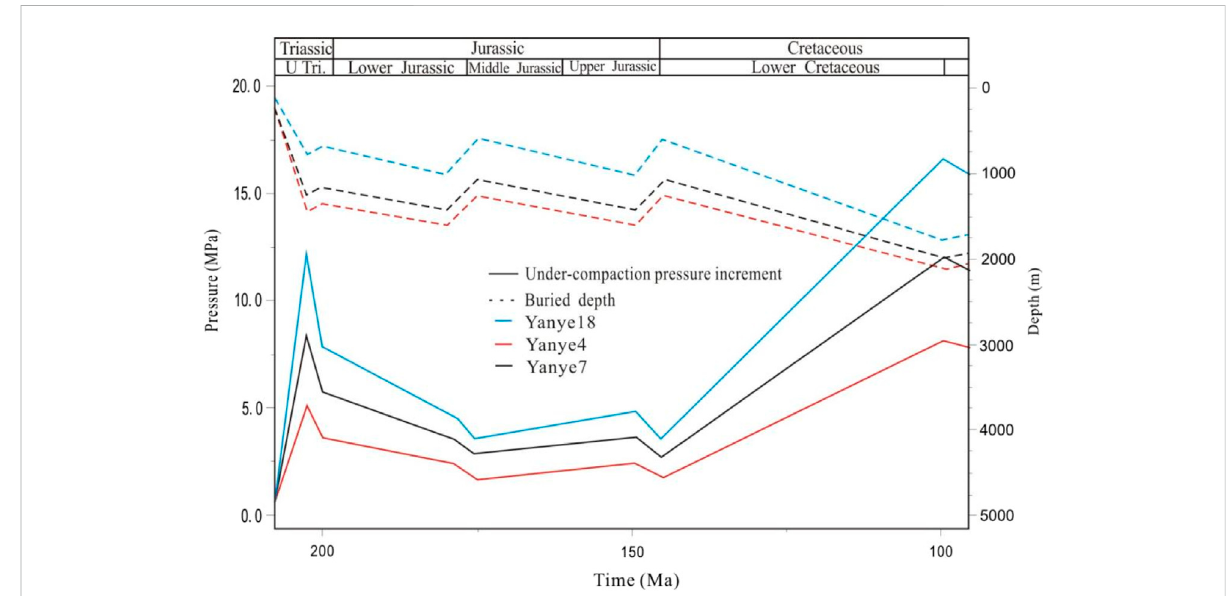
FIGURE 11 Evolution of excess pressure during disequilibrium compaction in the Chang 7 Member shale.